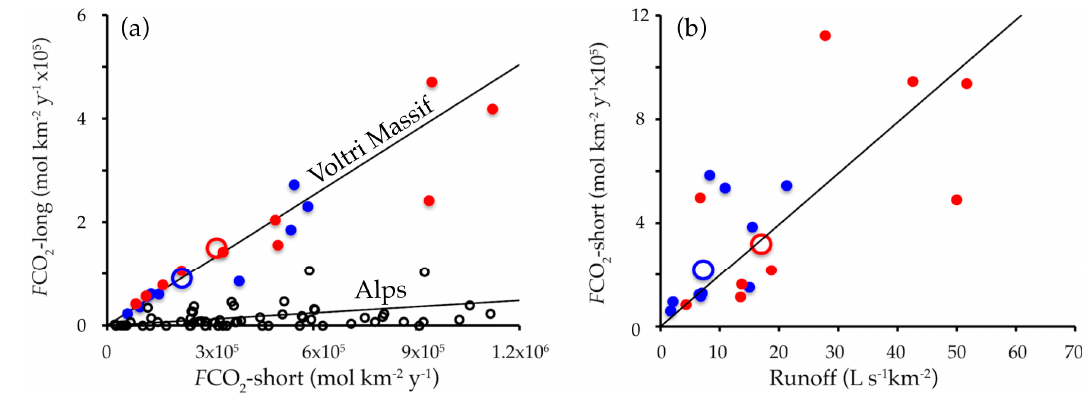
Figure 6. ( a ) F CO 2 -long vs. F CO 2 -short diagram. Red full circles indicate samples collected during the wet season, blue full circles indicate samples collected during the dry season; open circles indicate the weighted averages of the wet (red) and dry (blue) seasons. The samples of Voltri Massif are compared to the samples of the Alps (open black circles [23]). ( b ) F CO 2 -short vs. runo ff